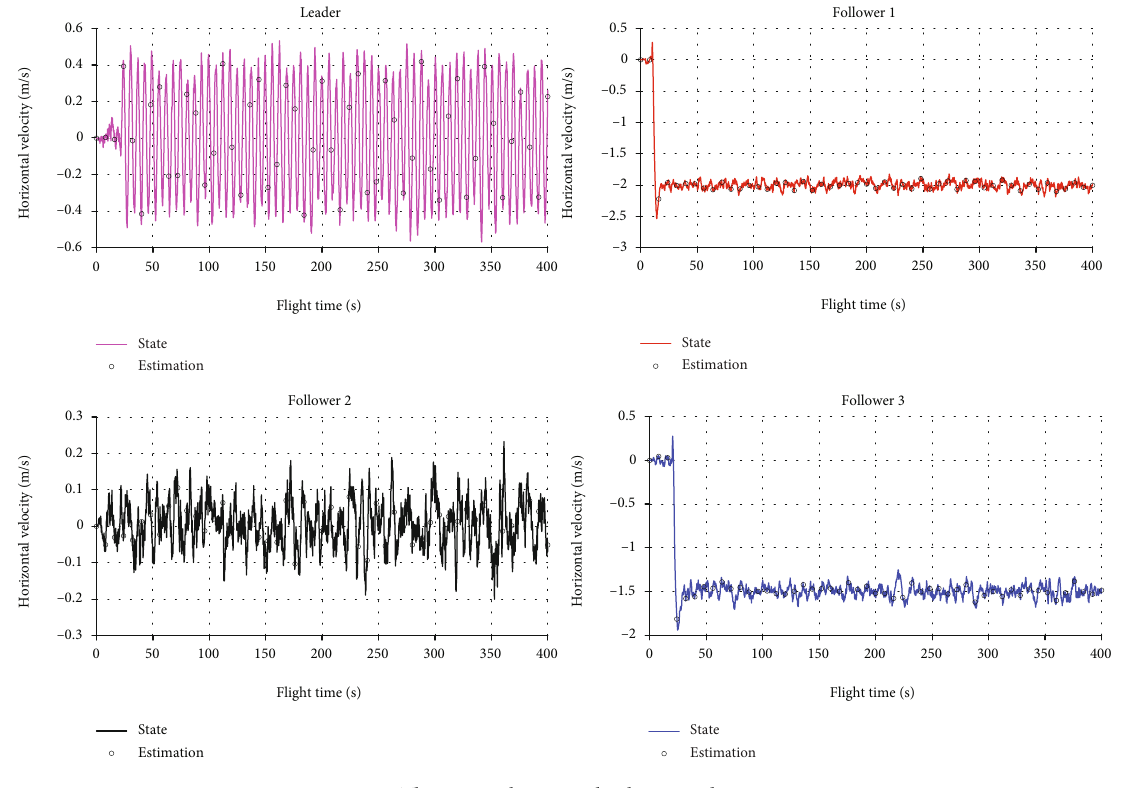
Figure 9: The system horizontal velocity and